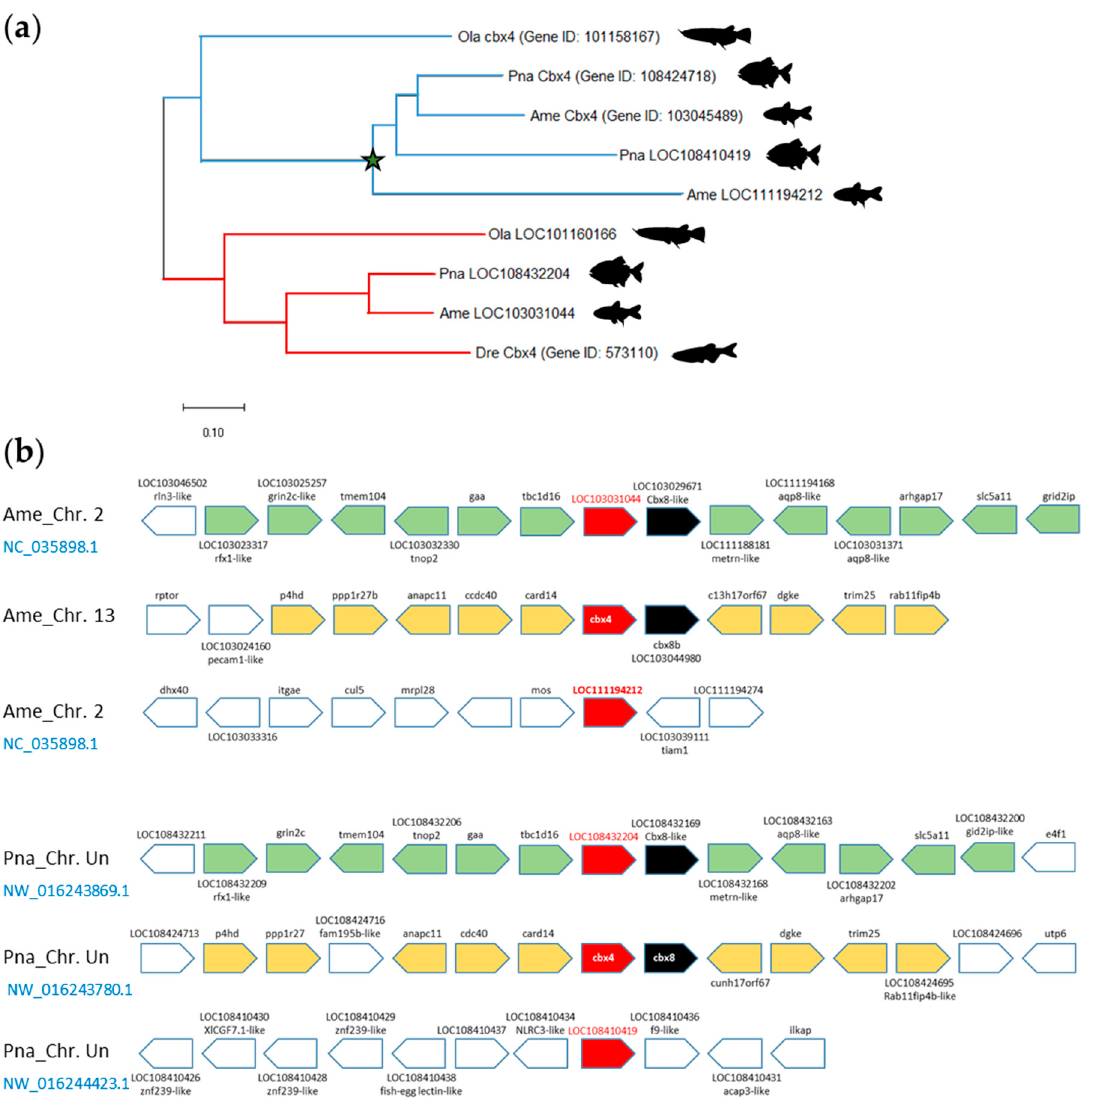
Figure 6. The cbx4 paralogues in Characiformes. ( a ) Phylogenetic tree of the evolutionary relationships between zebrafish (Dre, Danio rerio ) Cbx4 protein and its orthologues in medaka (Ola, Oryzia latipes ), Mexican cavefish (Ame, Astyanax mexicanus ) and red-bellied piranha (Pna, Pygocentrus nattereri ). The evolutionary history was built using the Neighbor-Joining method conducted in MEGA X. The star indicated a possible cbx4 gene duplication having occurred in Characiformes. ( b ) Blocks of synteny at the cbx4-cbx8 locus in Mexican cavefish and red-bellied piranha. The cbx4 genes are shown in red, cbx8 in black, while orthologous gene loci are highlighted with different colors. Chromosomal locations of cbx4 , cbx8 and the neighboring gene loci were drawn based on information from the NCBI Gene server. Chromosome (Chr.) numbers are indicated. Un, unplaced scaffold.